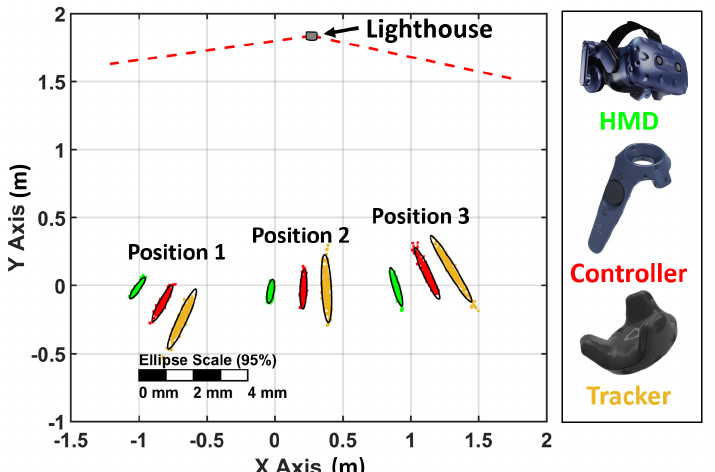
Figure 3. Noise pattern of all devices at three different positions with one lighthouse. Distance to lighthouse: 1.8 m. Individual position results (coloured dots), 95% confidence ellipses (black).